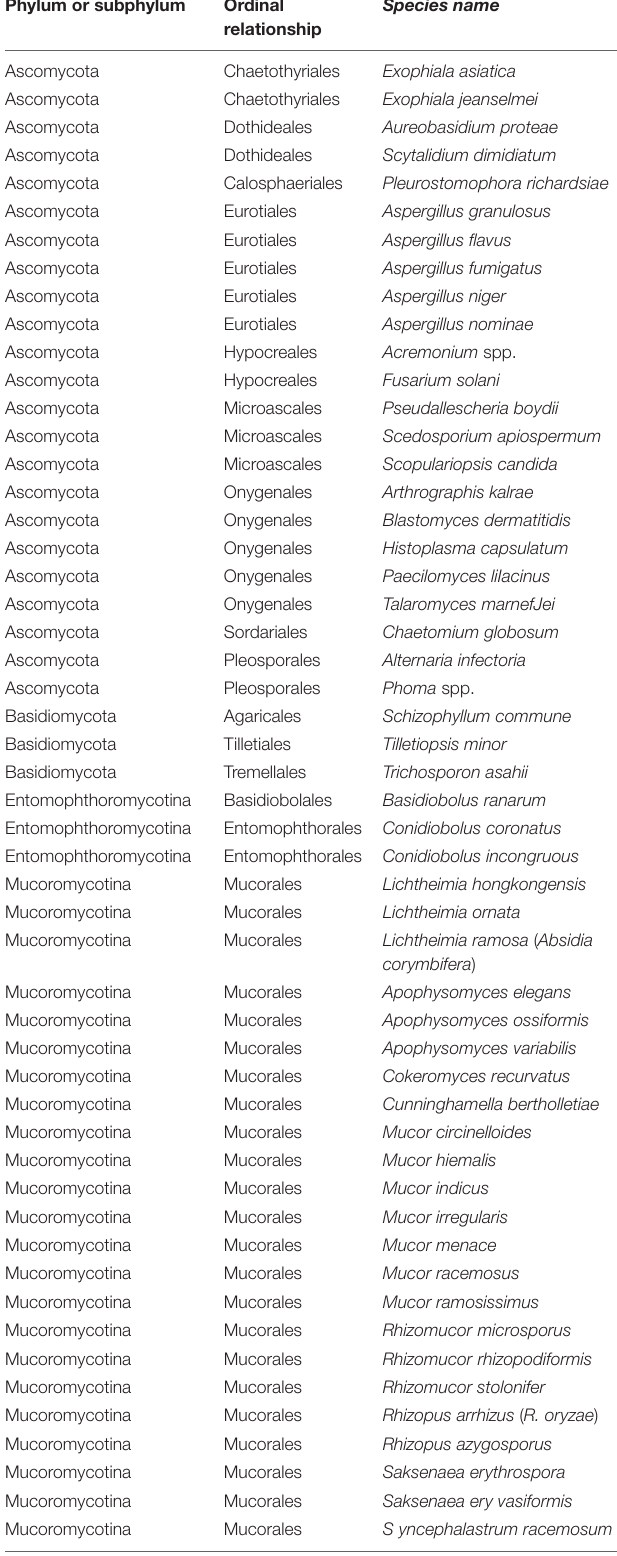
TABLE 1 | Aetiological agents of rhino-orbital-cerebral